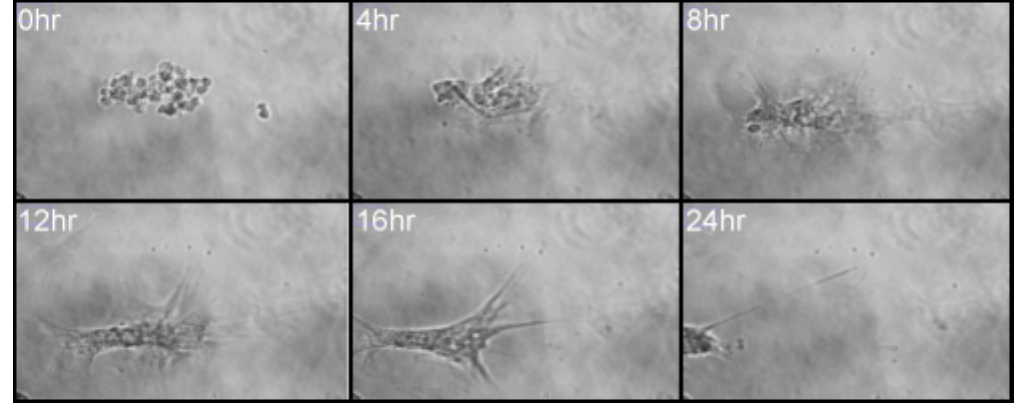
Figure 2. A montage of six images taken from the 24 h time ‐ lapse following a single MSC cultured within an Ibidi μ‐ Slide Chemotaxis 2D assay plate with IL ‐ 6/DMEM (1 ng/mL) in the first reservoir and culture media alone in the reservoir on the right.